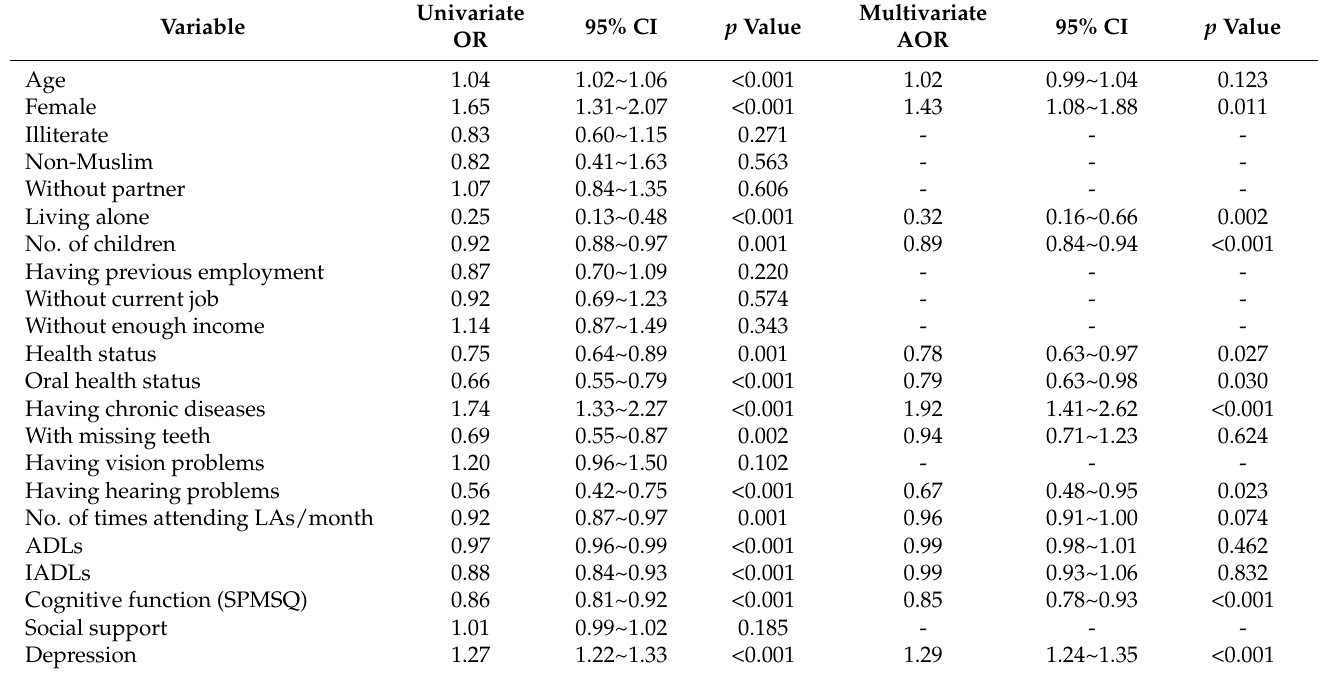
Table 2. Univariate and multivariate logistic regression analysis of loneliness ( N =